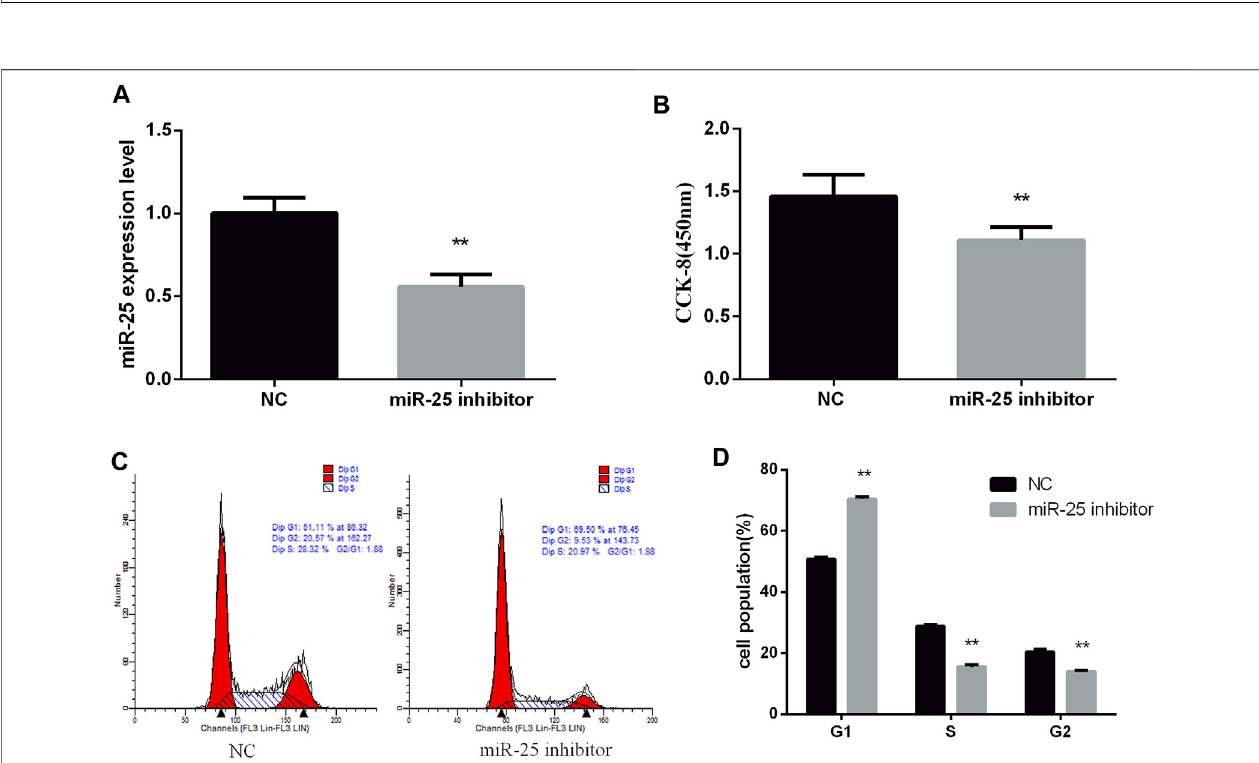
FIGURE2| InhibitionofmiR-25inhibitsBGC823cellgrowth. (A) AftertransfectionofmiR-25inhibitorintoBGC823cell,theexpressionlevelofmiR-25wasdetectedbyRT- qPCR. (B) After loss of miR-25, CCK-8 reagent was used to detect cell proliferation activity. (C) Cell cycle were analyzed by fl ow cytometry after being transfected with miR-25 inhibitor. (D) Statistical results of fl ow cytometry. Value in graphs represents means ± SD. At least three independent experiments were carried out. ** p < 0.01.